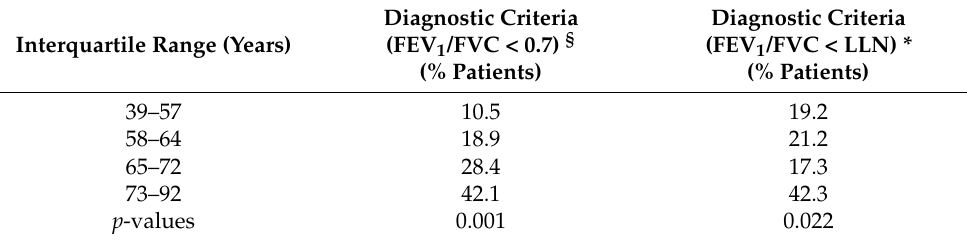
Table 4. Obstruction severity prevalence for two diagnostic criteria by interquartile range.